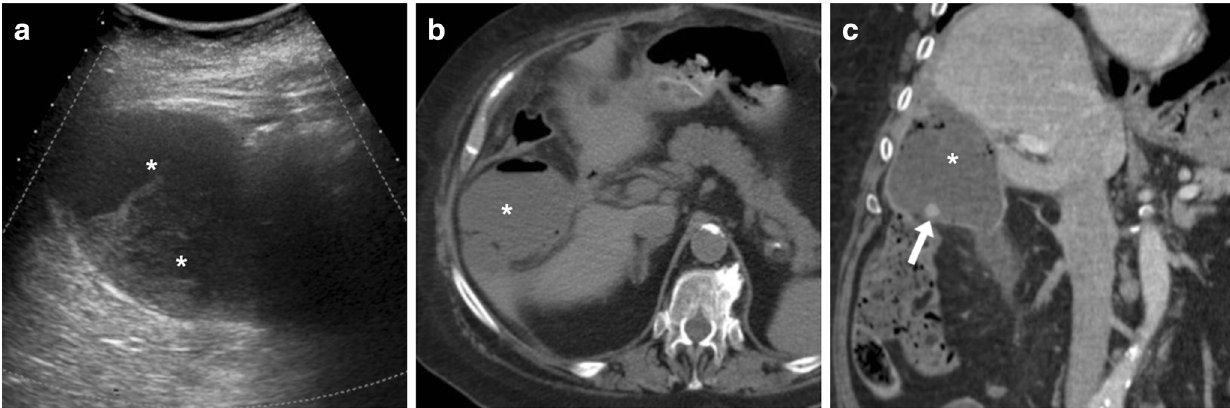
Fig. 10 Gallbladder fossa abscess (*) observed after open cholecystectomy converted from laparoscopic cholecystectomy because of gallbladder perforation and intraperitoneal spillage of infected bile, sonographically( a ) seen asovoid well-demarcated infrahepaticcollection with inhomogeneous hypo-anechoic structure. Unenhanced ( b ) and post- contrast ( c ) CT images confirmed abscess collection occupying the